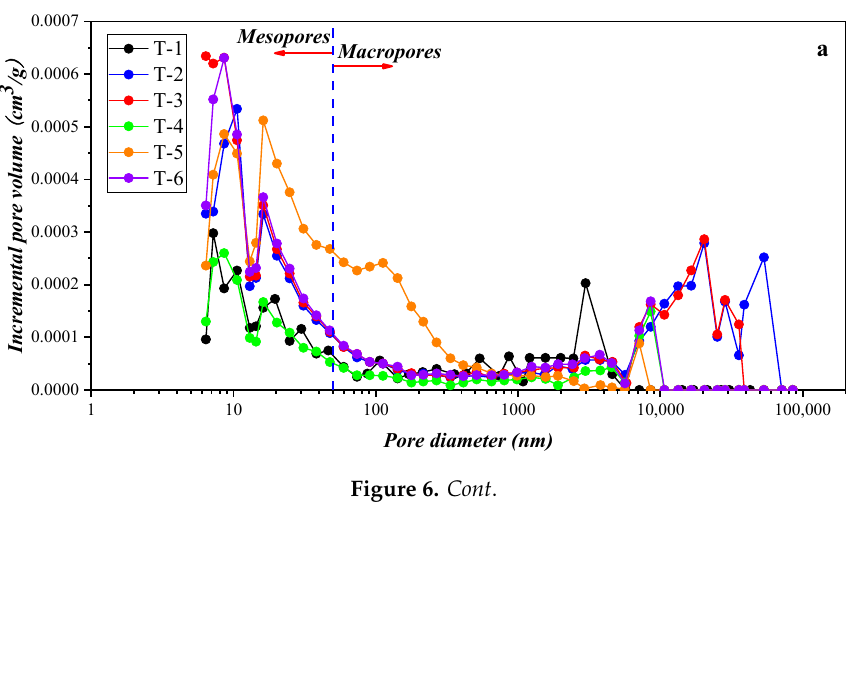
Figure 6. Pore size distribution by the high-pressure mercury injection experiment for the 12 shale samples: (a) The first six shale samples, (b) The last six shale samples. 3.4. Methane Adsorption Experimental Data Figure 7 shows the excess methane adsorption data of these shale samples and fitting curves using Equation (1). Moreover, Figure 8 illustrates the absolute methane adsorption data under each pressure of these shale samples. In addition, all the adsorption data in Figure 8 are fitted by the Langmuir equation. The Langmuir volume, indicating the maximum methane adsorption capacity, of all the shale samples ranges from 0.78 cm 3 /g to 9.26 cm 3 /g, and the Langmuir pressure ranges from 2.86 MPa to 9.43 MPa. When the pressure is 27 MPa, the excess adsorption volumes of methane in the 12 shale samples are in the range of 0.2–7 cm 3 /g (Figure 7), and the absolute adsorption volumes of methane range from 0.5 cm 3 /g to 8.5 cm 3 /g (Figure 8). The T-5 shale sample always has the smallest excess and absolute adsorption volumes, and T-11 has the largest excess and absolute adsorption volumes. This result may be because the T-5 shale sample has the lowest TOC content and T-11 has the highest TOC content (Table 1).